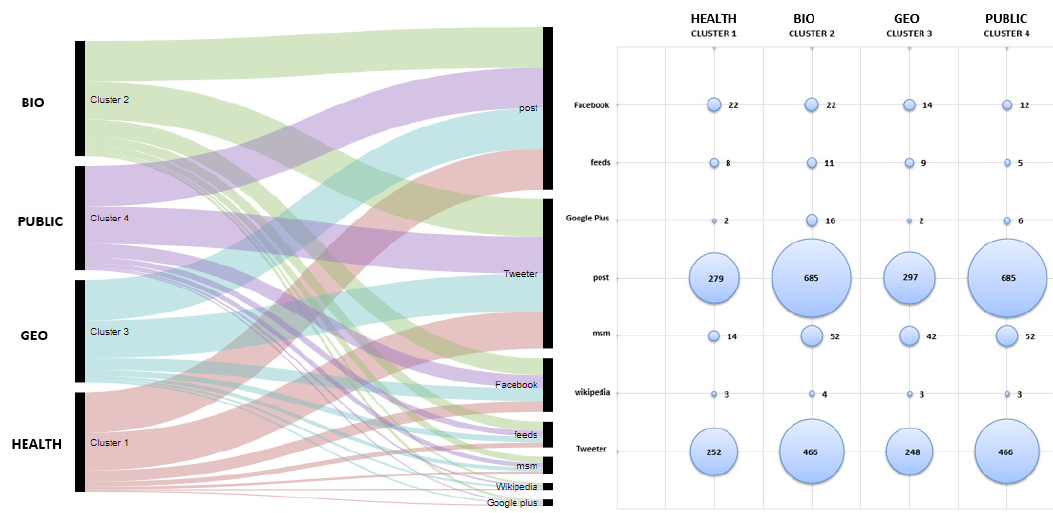
Figure 9. Mentions in social networks by cluster ( left ) and maximum number of mentions ( right ).